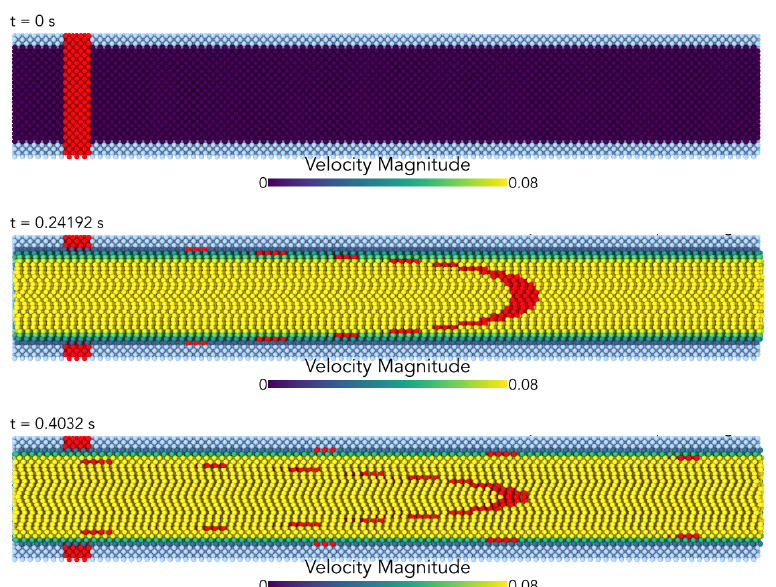
Figure 23. Snapshots of timelines evolution (tracking particles) in a pipe for a Newtonian viscous flow, obtained at three different instants. At third instant particles are going through the domain for the second time, as per periodic configuration. Flow obtained with: (cid:101) CS = 0, ρ = 1 × 10 3 , c = 1 × 10 − 1 , µ = 1 × 10 − 3 , g = 5 × 10 − 1